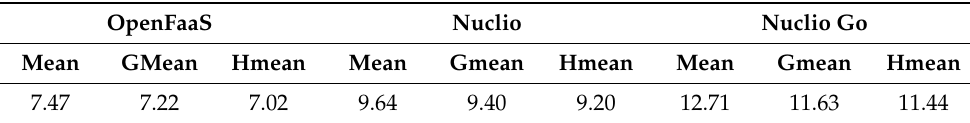
Table 3. Byte reversal single request: arithmetic mean, geometric mean and harmonic mean for throughput in